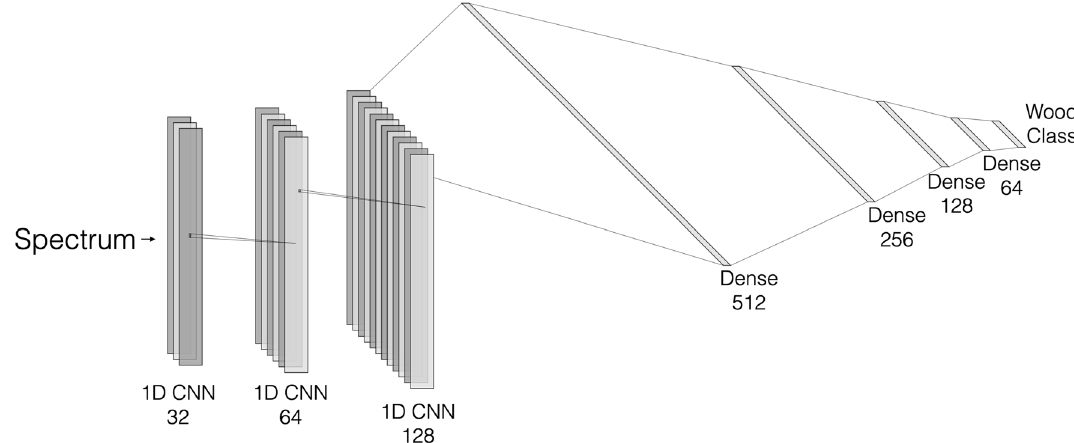
Figure 2:. 1D CNN Architecture for classification.